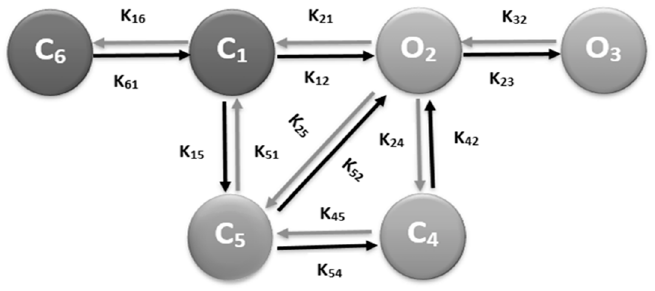
Figure 2. Schematic diagram of the 6-state Markov model of the L-type Ca 2+ channel.